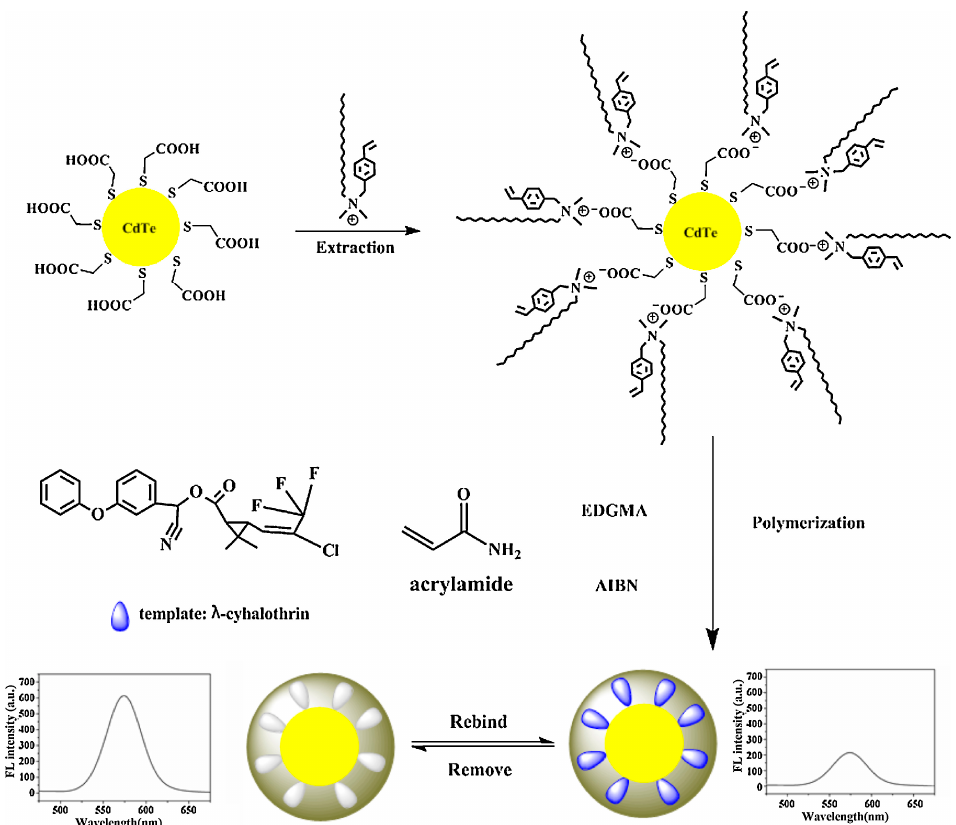
Figure 7. The preparation principle of fluorescent molecularly imprinted polymers (FIPs) for Figure7. Thepreparationprincipleoffluorescentmolecularlyimprintedpolymers(FIPs)forrecognizing recognizing cyhalothrin. Reprinted with permission from [89], copyright (2016) Elsevier. cyhalothrin. Reprinted with permission from [89], copyright (2016)